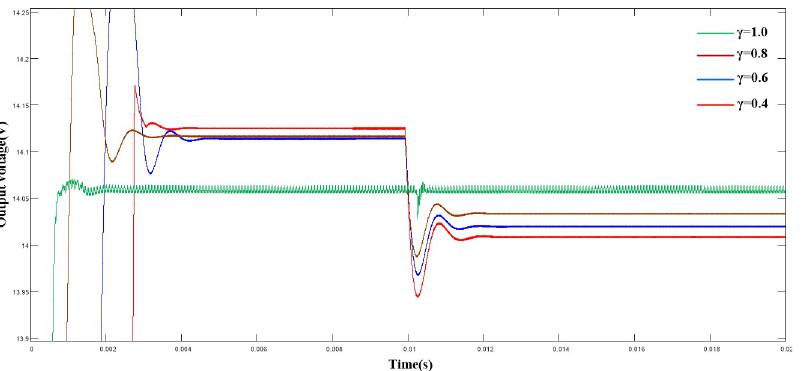
Fig 7. Comparison of output voltage waveforms with different γ values under load